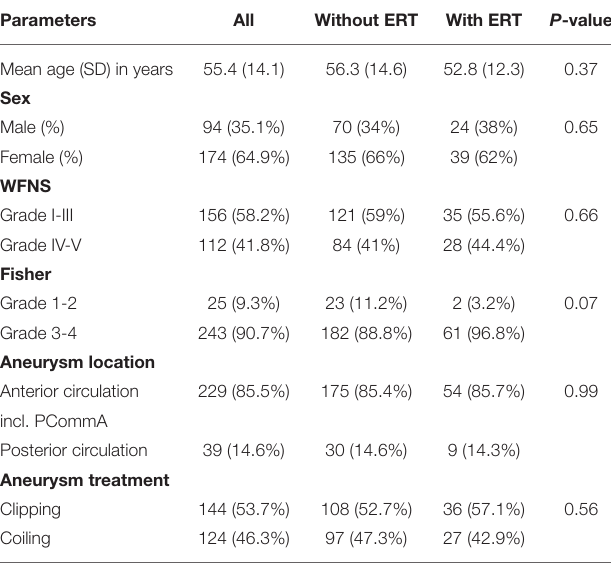
TABLE 1 | Baseline characteristics of the study